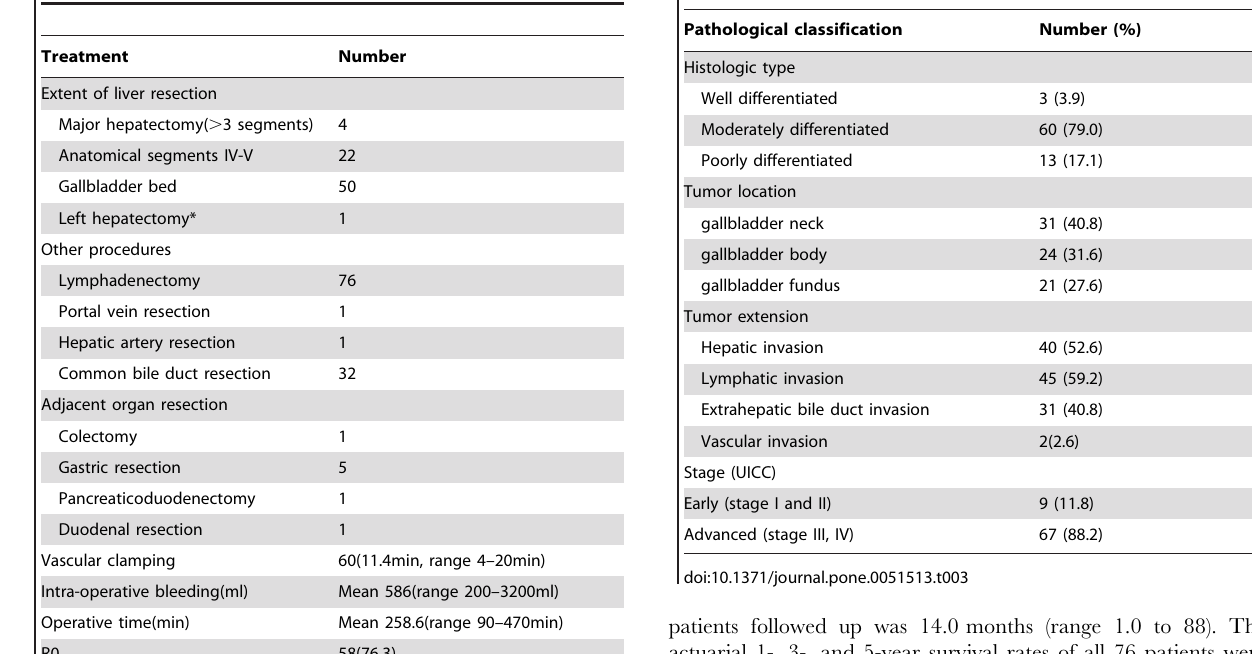
Table 3. Pathological characteristics of the 76 GBC.